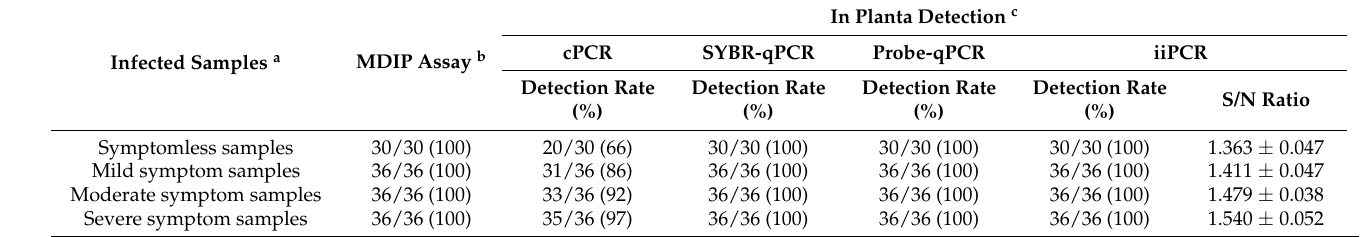
Table 3. Comparison of Fo iiPCR and molecular methods for field detection of various Fusarium oxysporum -infected asymptomatic and symptomatic samples using an automated DNA extraction